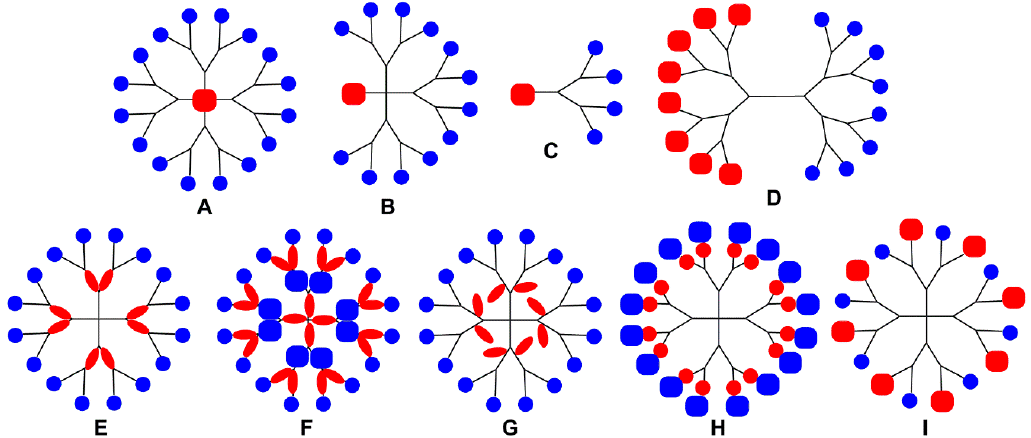
Figure 1. Types of bi-functional dendrimers. ( A – C ) one function at the core different from the terminal functions; ( E – G ) functions inside the structure, at one or several layers, different from the terminal functions; D , H , and I : two types of terminal functions.